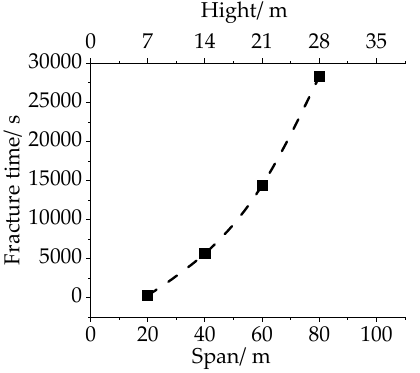
Figure 22. Fracture time of different models.